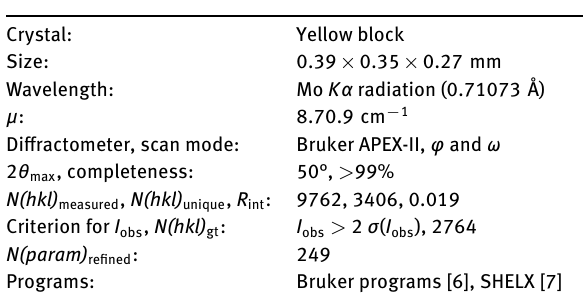
Table 1: Data collection and handling.